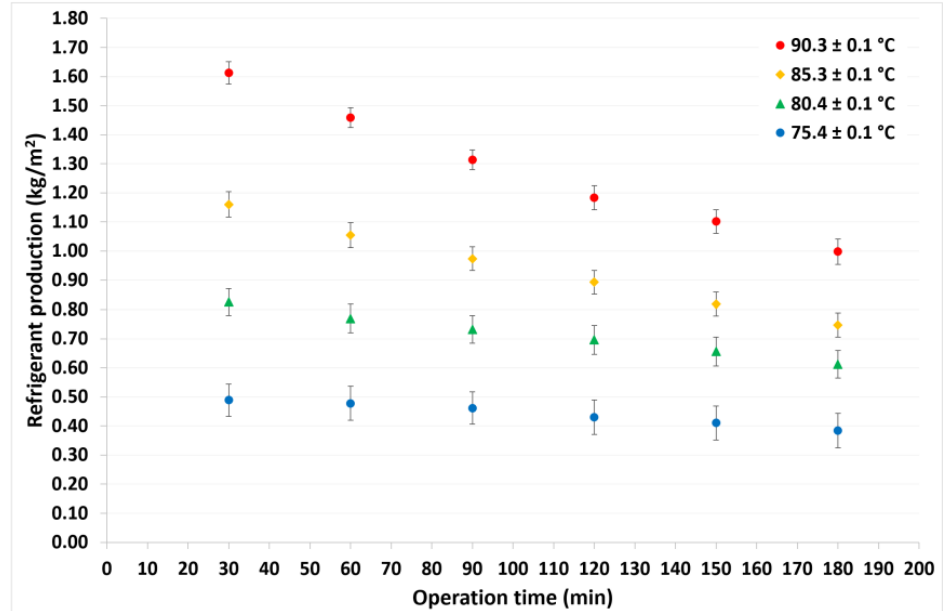
Figure 7. Refrigerant production as a function of operation time.